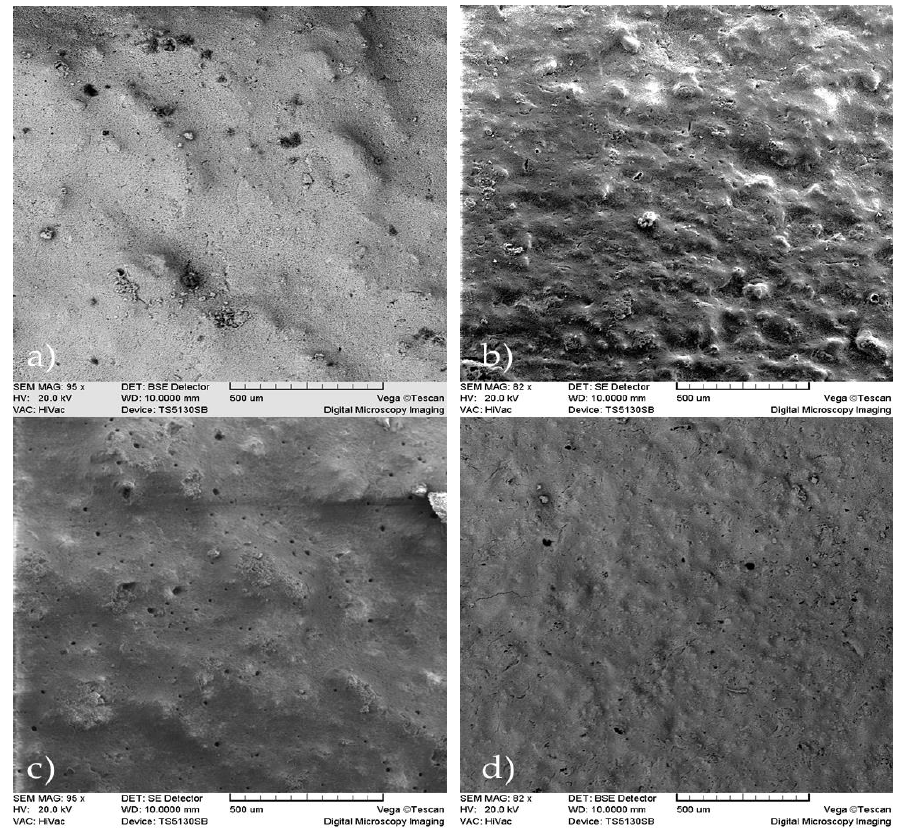
Figure 2. SEM micrographs of the samples: ( a ) A2T0, ( b ) A2T1, ( c ) A5T0 and ( d ) A5T1, (scale bar = 500 µm) .